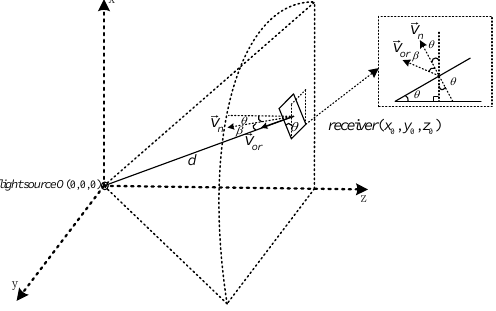
Figure 1. Geometric configuration model of UWOC system.